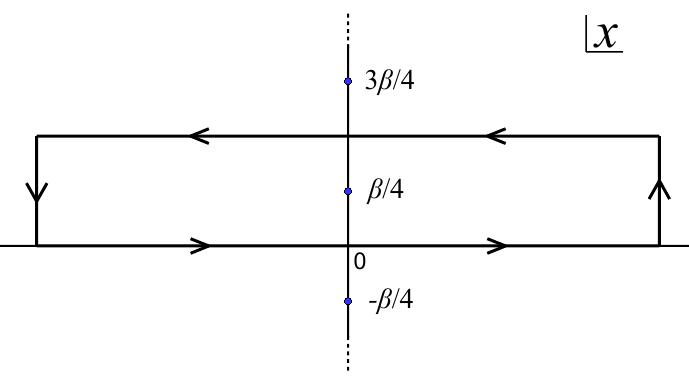
Figure 5 . Poles of the potential (3.2). It has one pole at the center of the strip, x = i(cid:12)= 4, and in(cid:12)nitely many copies due the periodicity x ! x + i(cid:12)=